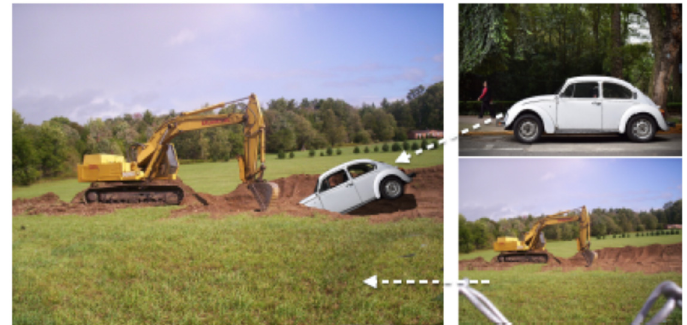
Figure 1. A fake image is created by splicing together content from two different images [1].